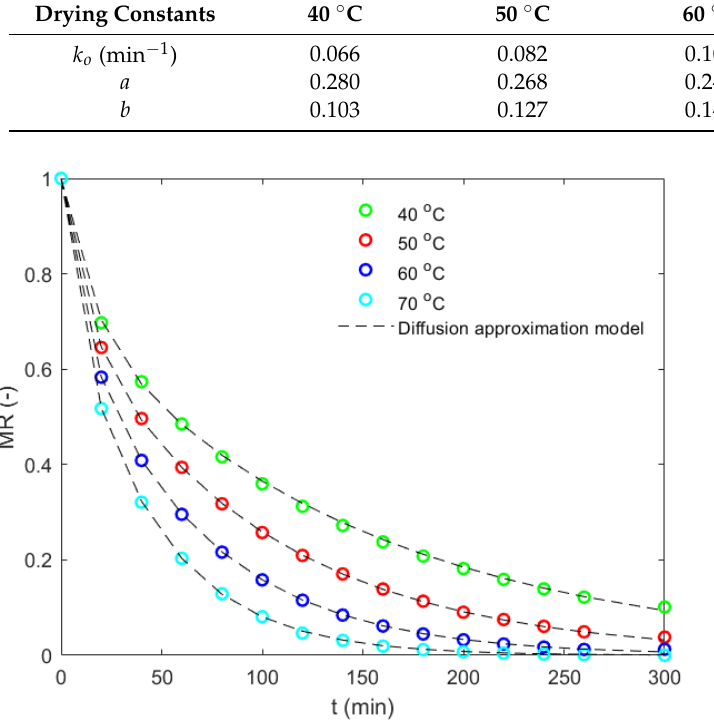
Table 3. The drying constants for the diffusion approximation model at different temperatures from 40 to 70 ◦ C. Drying Constants